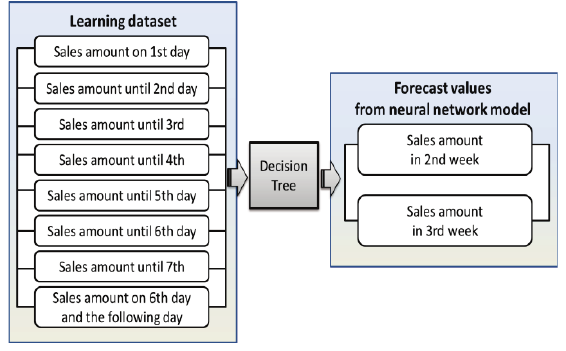
Fig. 8. Construction of decision